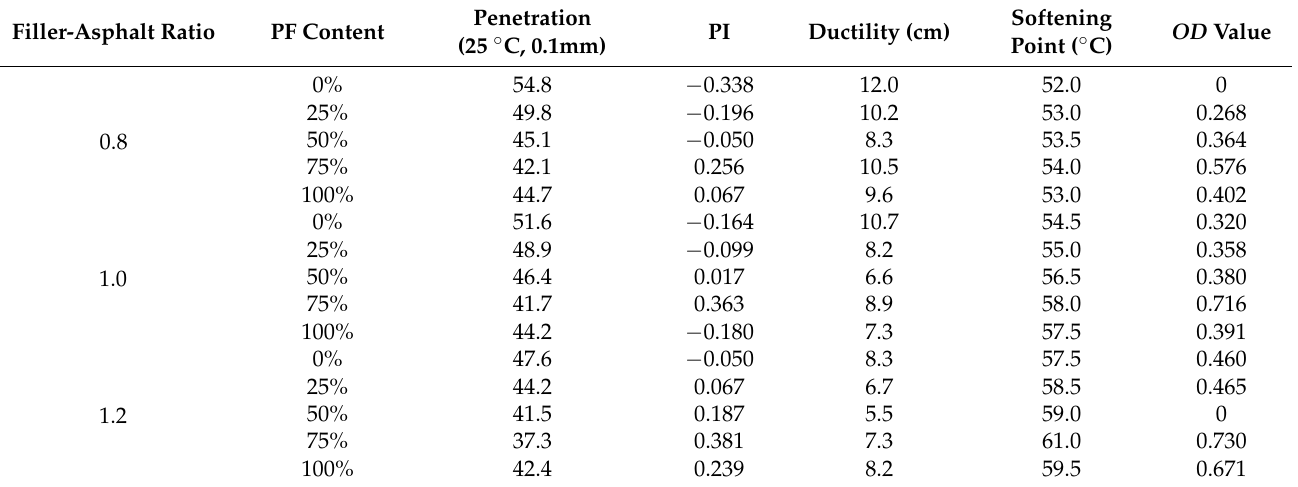
Table 8. Overall